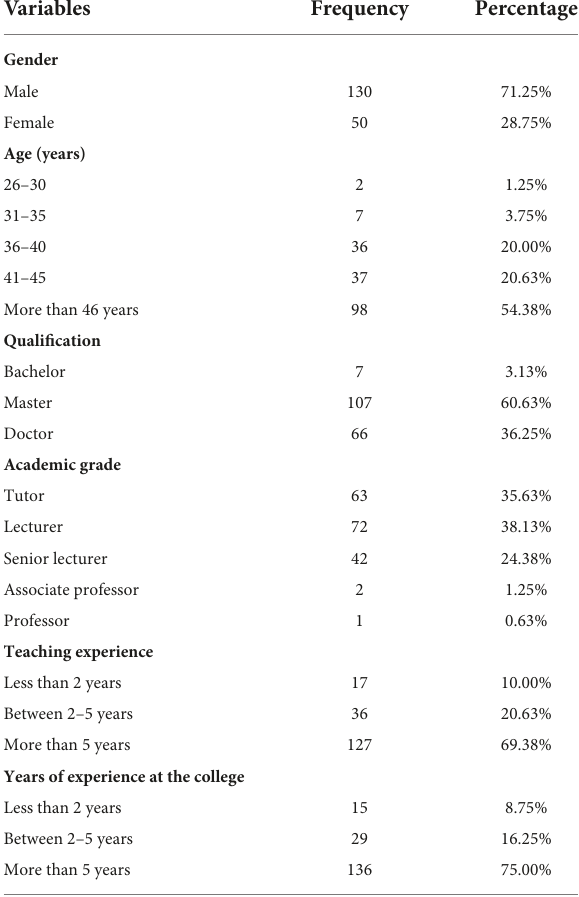
TABLE 2 Demographic profile of participants ( n = 160).